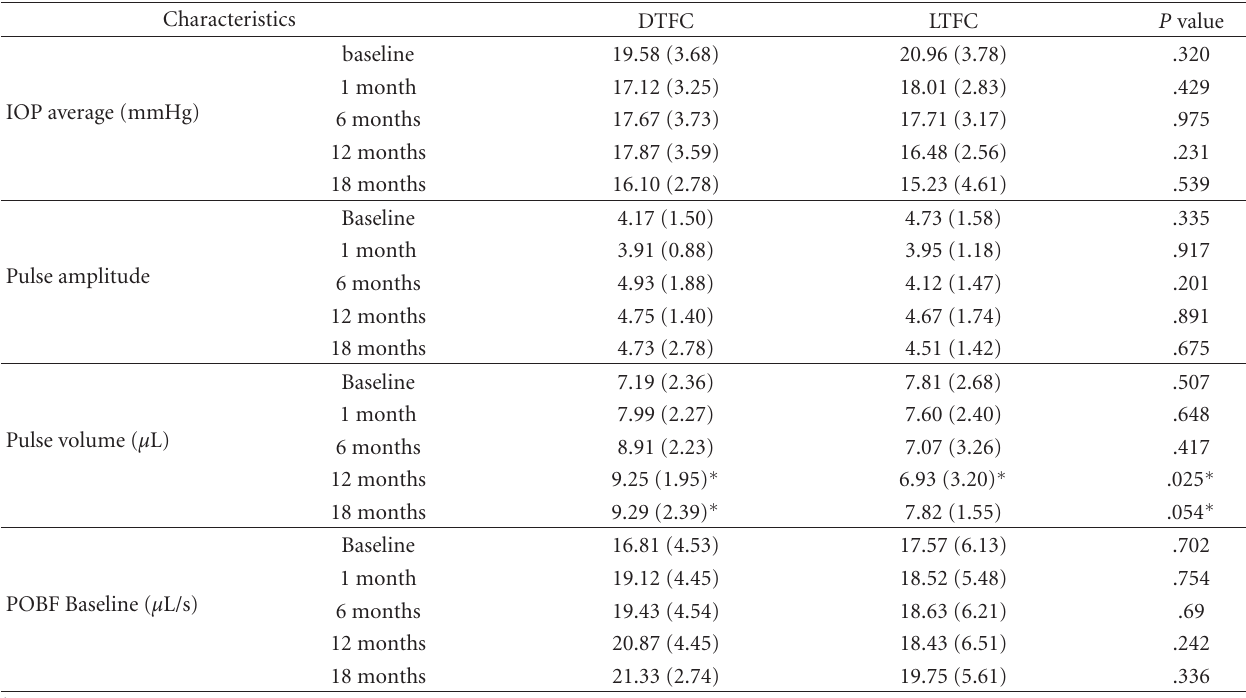
Table 3: Pulsatile ocular blood flow